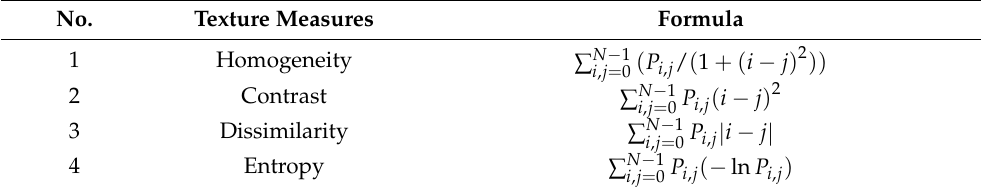
Table A1. Formulas for calculating textural features from gray-level cooccurrence matrix.